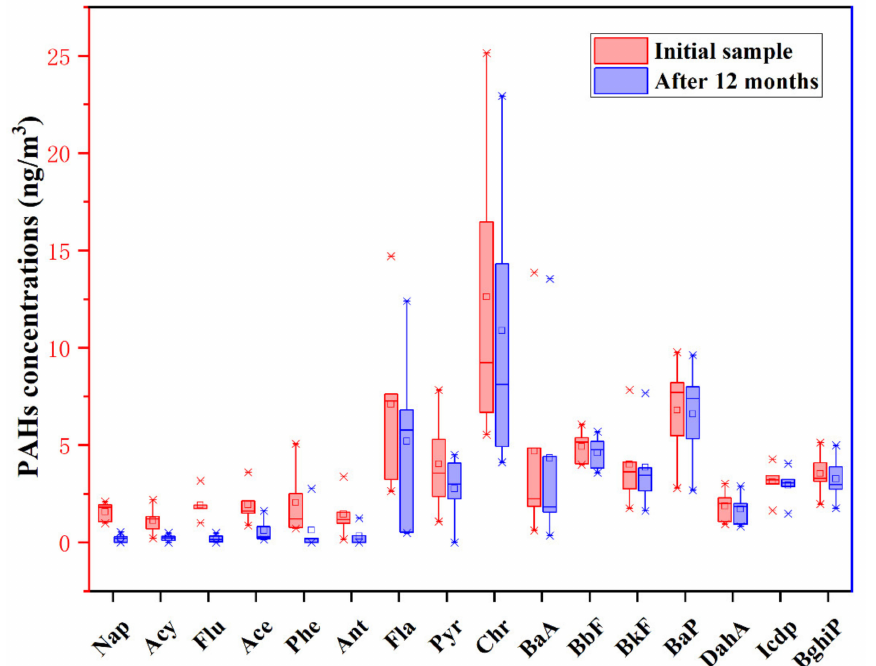
Figure 4. Concentration changes in 16 PAHs after storage for 12 months.